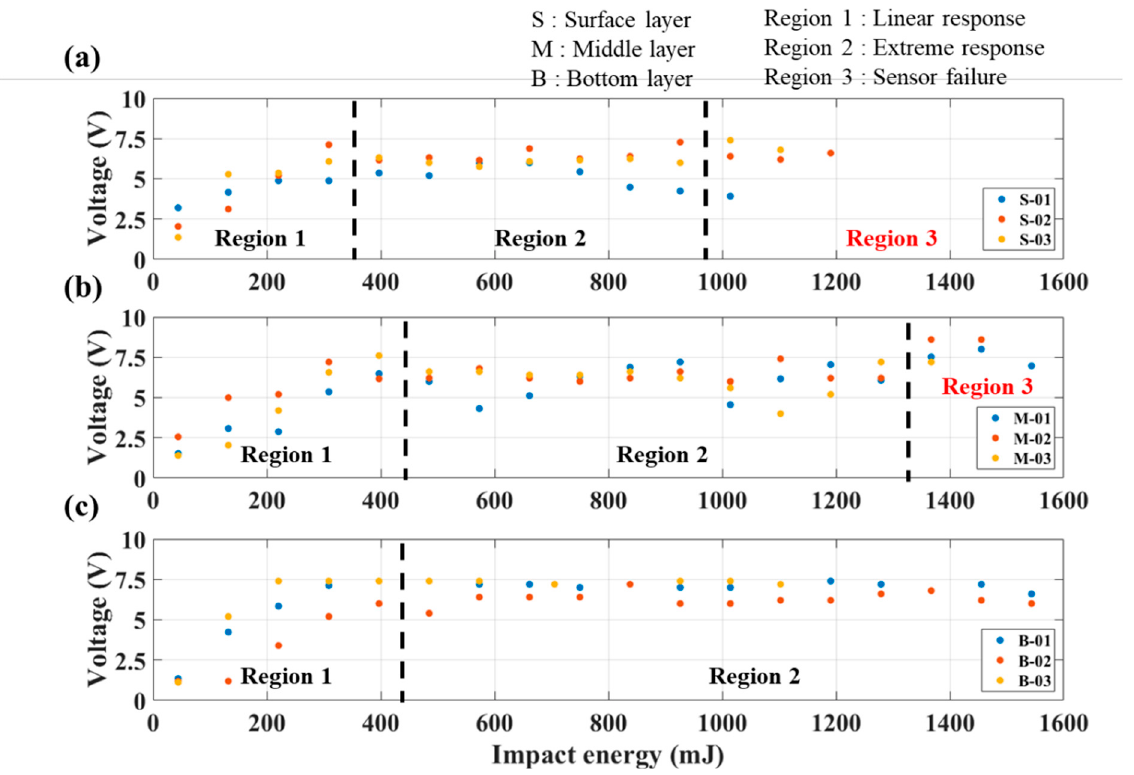
Figure 11. Piezoelectric response versus impact energy at the ( a ) surface, ( b ) middle, and ( c ) bottom of the specimen.